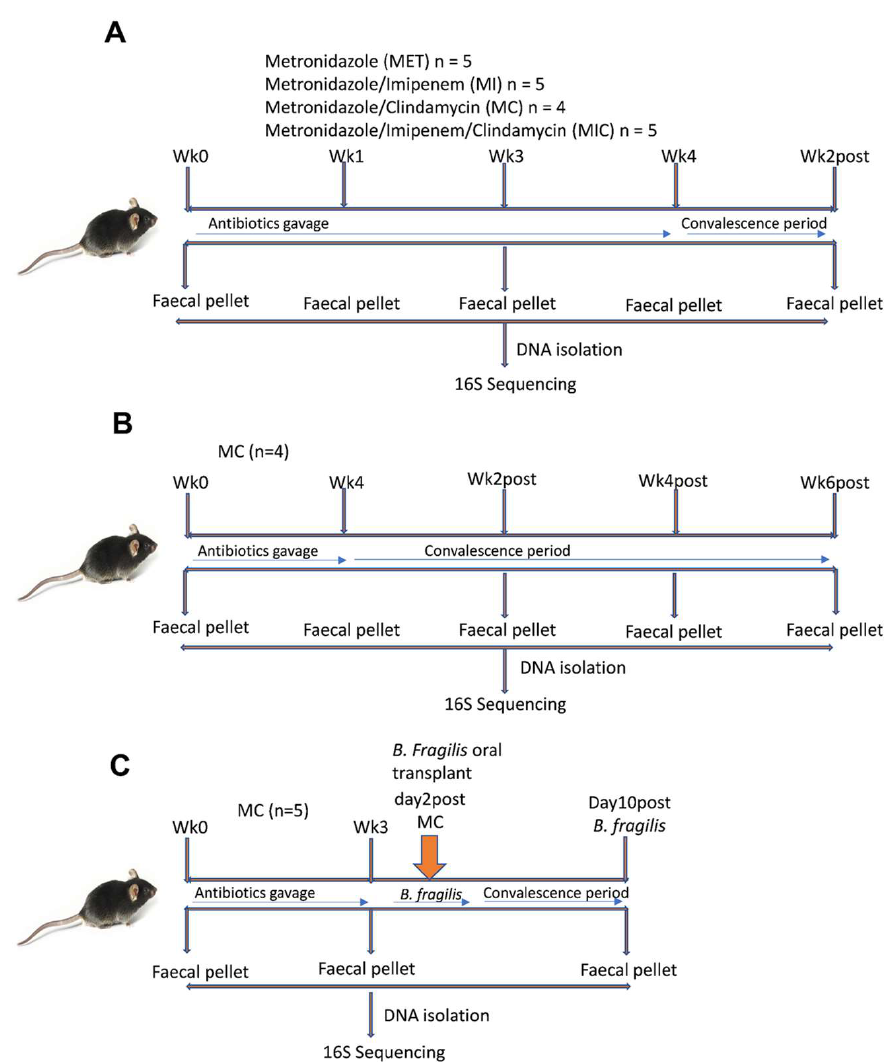
Figure 1. Experimental design for the different antibiotics’ treatment and B. fragilis engraftment ( A ) first experiment with four different groups of mice treated with metronidazole, metronidazole + imipenem, metronidazole + clindamycin, and metronidazole + imipenem + clindamycin, respectively ( B ) metronidazole + clindamycin repeated treatment in an independent experiment with convalescence timepoint extended to six weeks ( C ) metronidazole + clindamycin treatment followed by Bacteroides fragilis inoculation. n = 4–5 mice/group in each experiment.